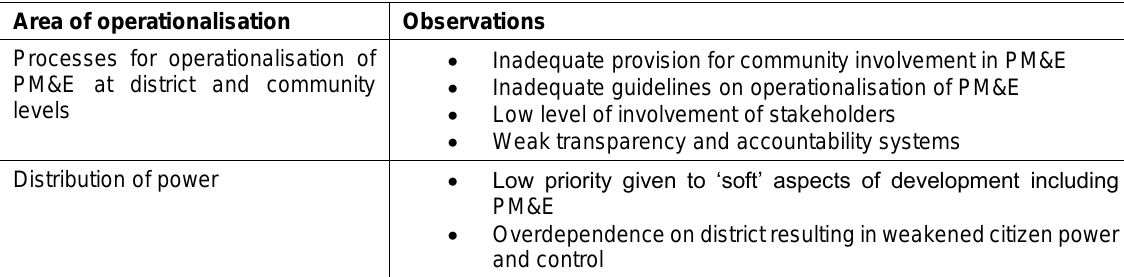
Table 2: Summary of issues on operationalisation of PM&E in DACF